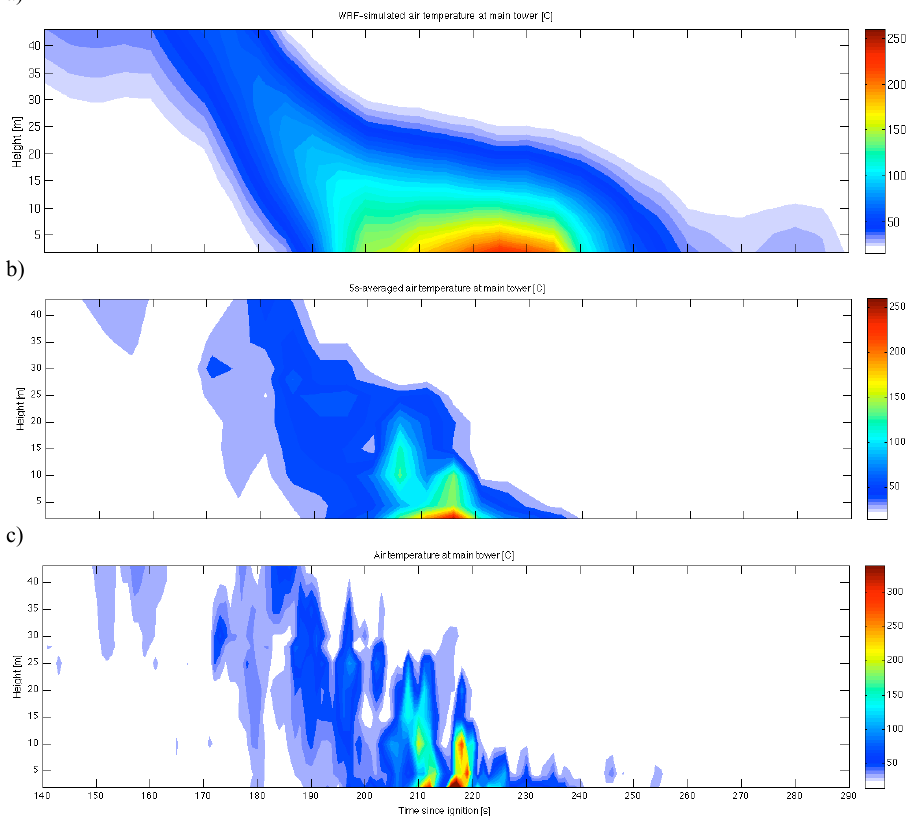
Figure 7. Air temperatures at the MT as a function of time: a) WRF-simulated, b) thermocouple 5s averaged, c) thermocouple raw (1s). Fig. 7. Air temperatures at the MT as a function of time: (a) WRF-simulated, (b) thermocouple 5s averaged, and (c) thermocouple raw (1s).